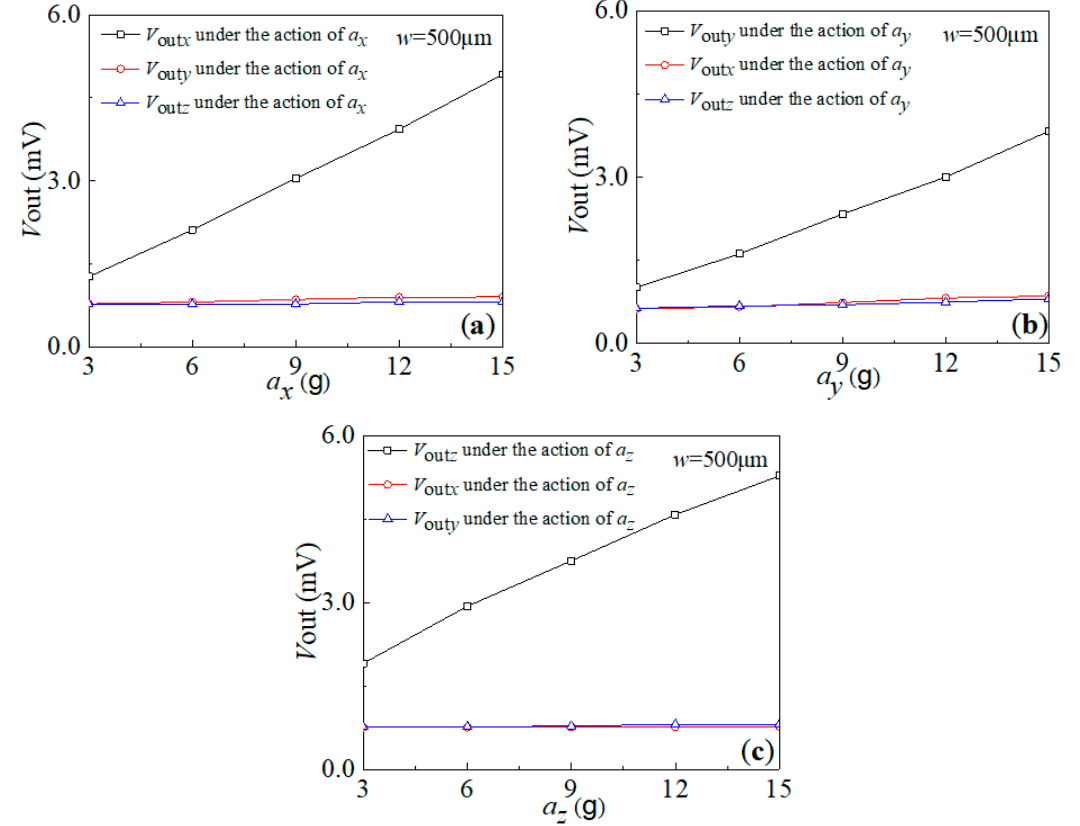
Figure 9. The cross-interference characteristic curves of the AS-6 sensor under three-axis acceleration along: ( a ) x -axis; ( b ) y -axis; ( c ) z -axis.